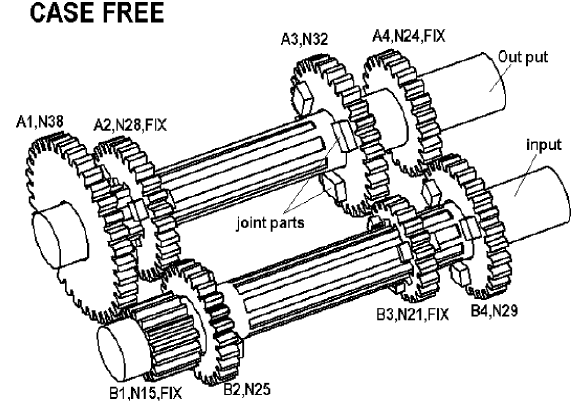
Fig. 1. The position of the gears in the